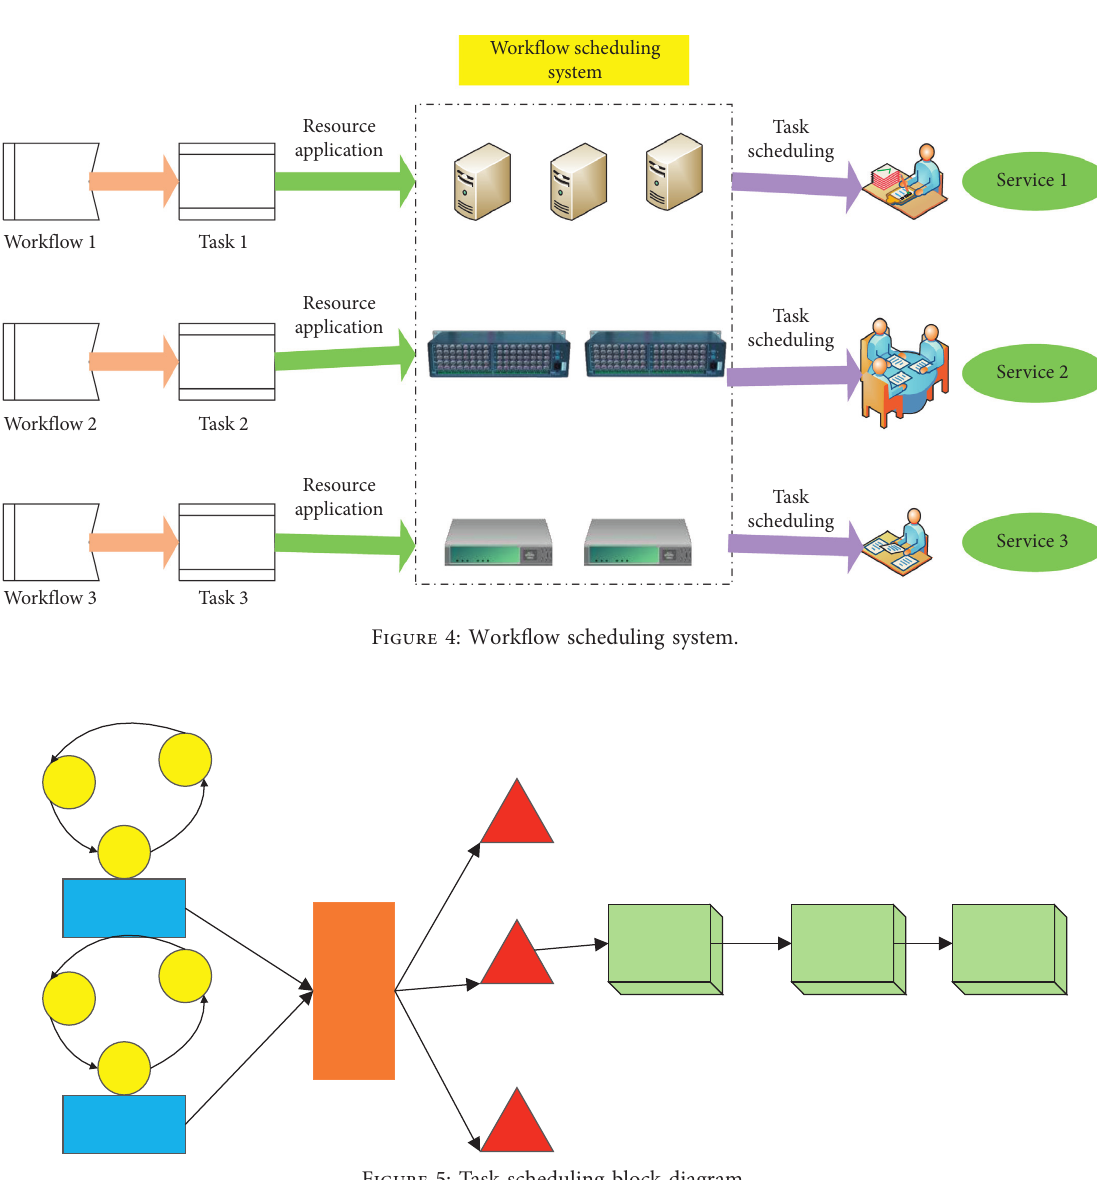
Figure 5: Task scheduling block